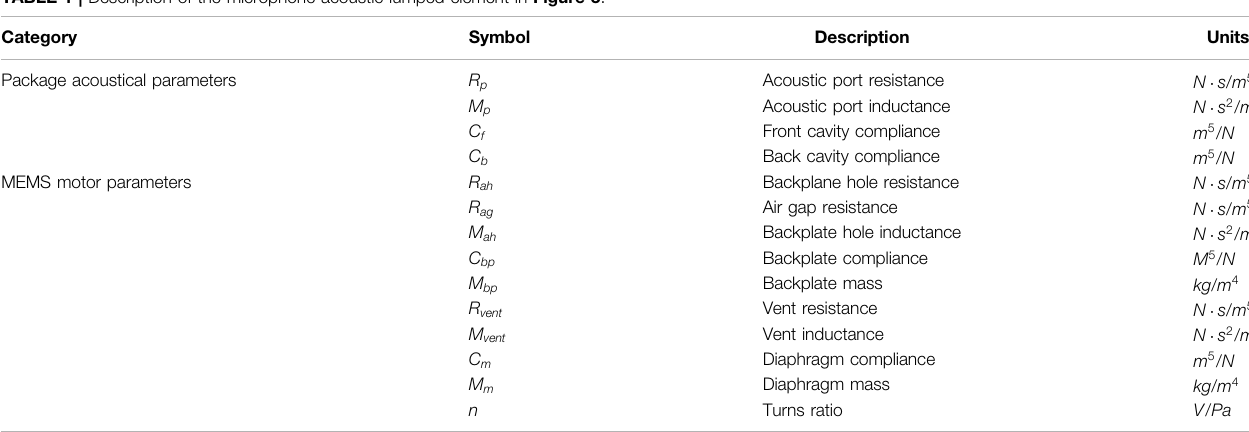
TABLE 1 | Description of the microphone acoustic lumped element in Figure 3 .